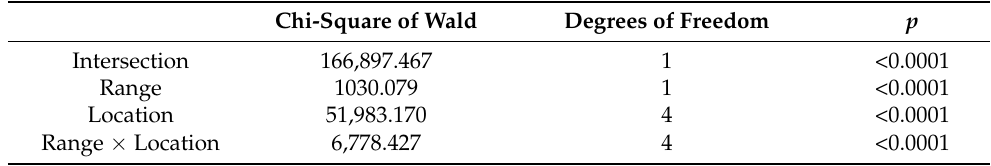
Table 1. Generalized Linear Model for sediment electrical conductivity comparing between distribu- tion ranges (native and invaded) and locations (ordered according to their distance to the ocean). Chi-Square of Wald Degrees of Freedom p Intersection 166,897.467 1 <0.0001 Range 1030.079 1 <0.0001 Location 51,983.170 4 <0.0001 Range × Location 6,778.427 4 <0.0001